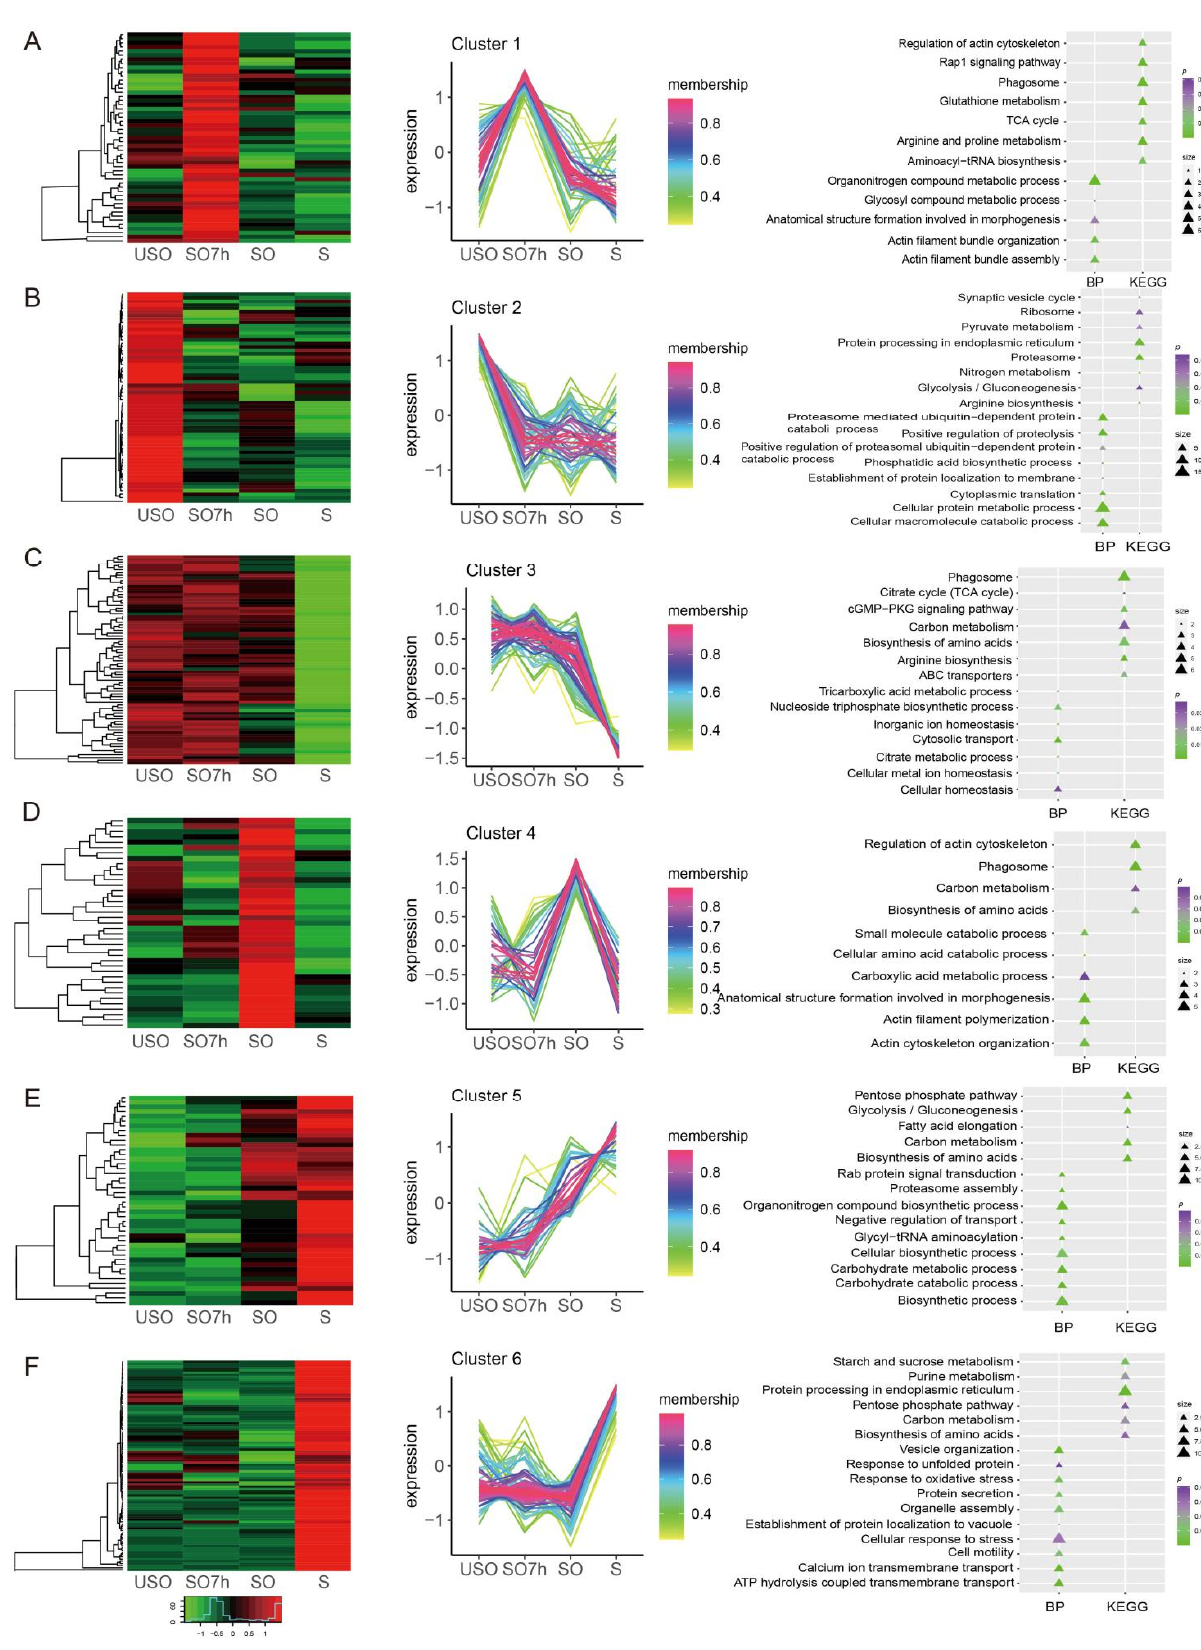
Figure 3. Protein phosphorylation heatmap, time series profiles, and functional enrichment results for ( A ) Cluster1, ( B ) Cluster 2, ( C ) Cluster 3, ( D ) Cluster 4, ( E ) Cluster 5, and ( F ) Cluster 6.